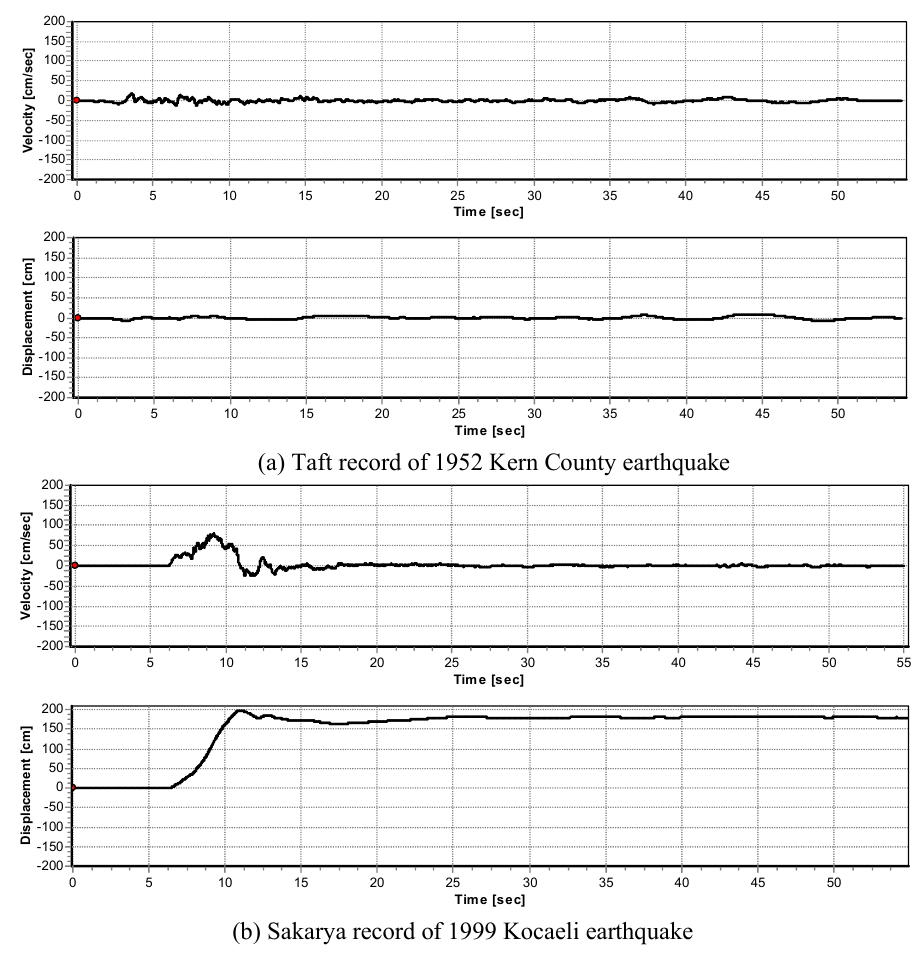
Figure 2. Typical velocity and displacement time histories of: (a) far-fault, (b) near-field (fling step) ground motions. Fig. 2. Typical velocity and displacement time histories of (a) far-fault and (b) near-field (fling step) ground motions.